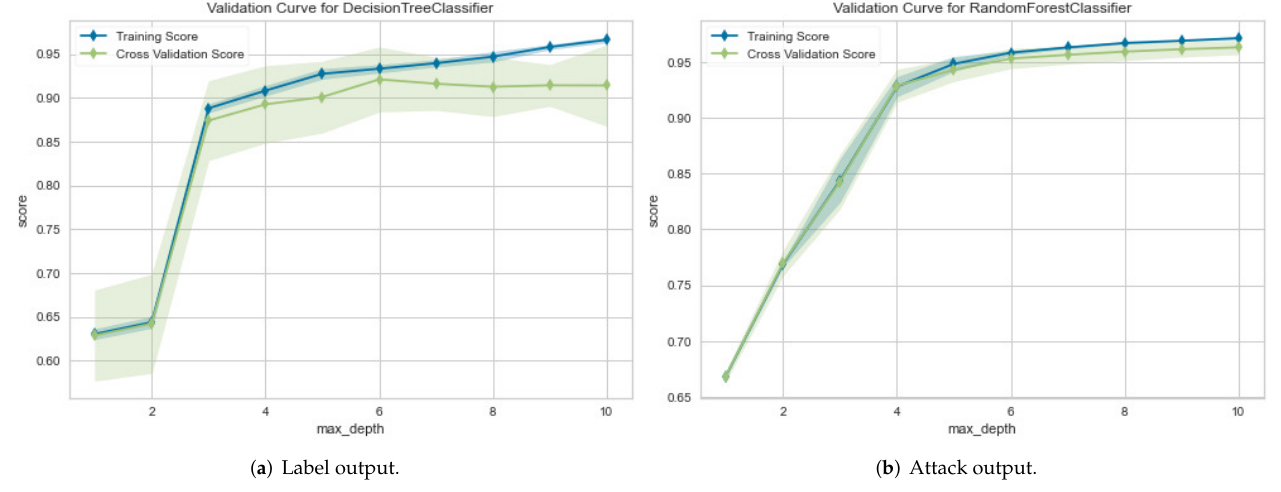
Figure 9. Validation curve results for NF-BoT-IoT-v2 of NetFlow V2 dataset in two cases: ( a ) Binary class output and ( b ) Multiclass output.